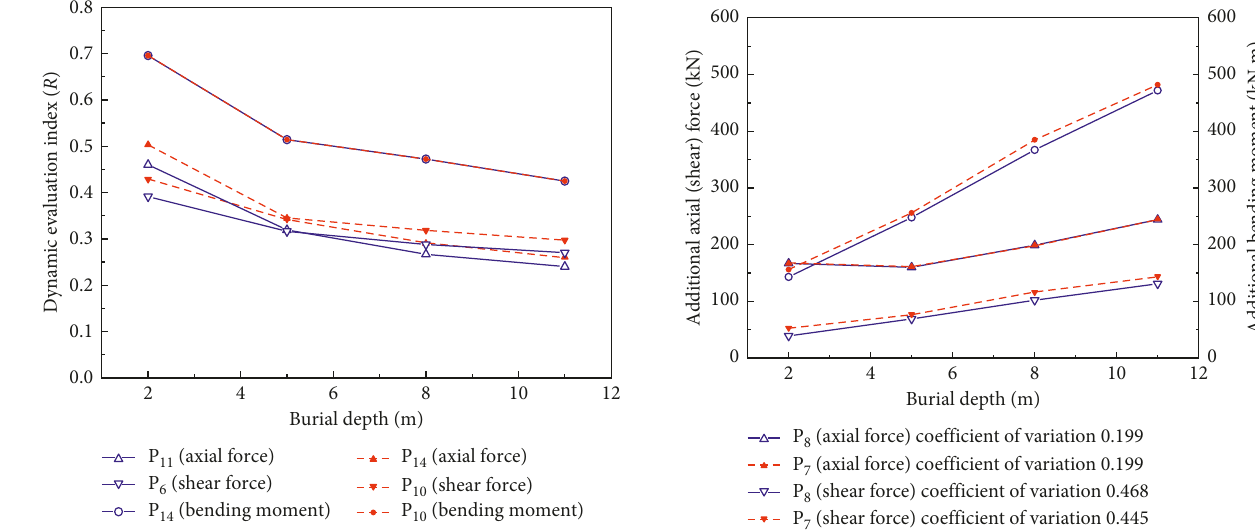
Figure 14: Variations of the dynamic index with burial depths at typical sections.